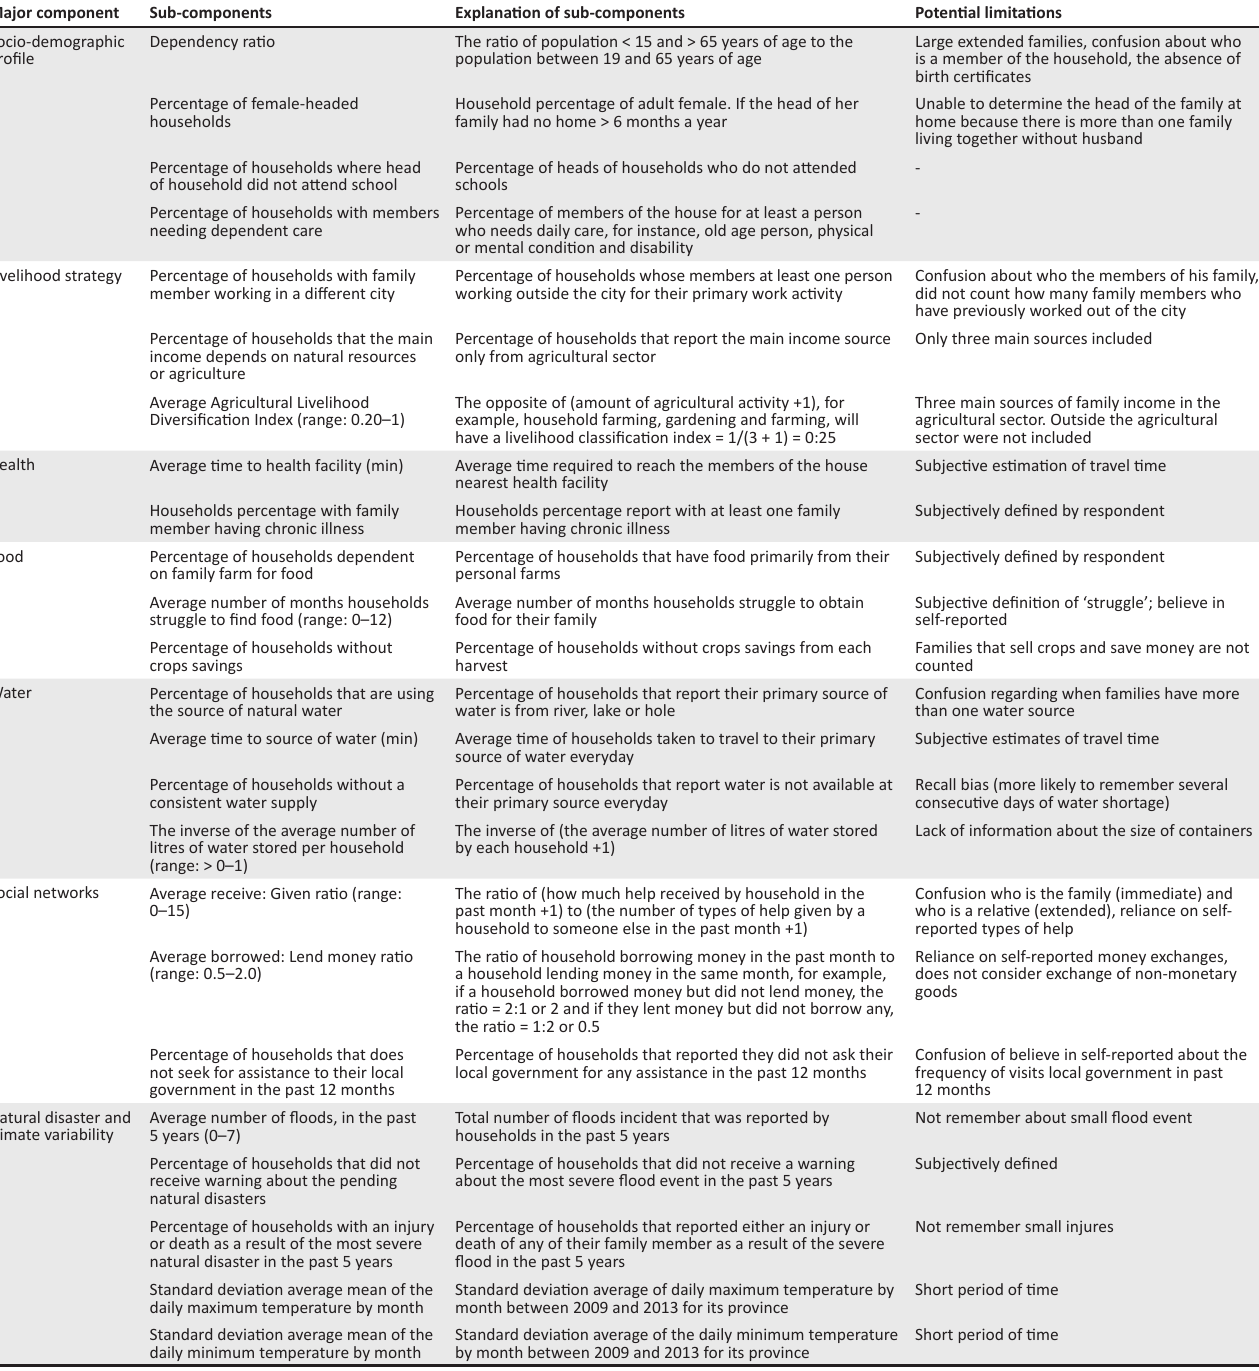
TABLE 2: Design of the livelihood vulnerability